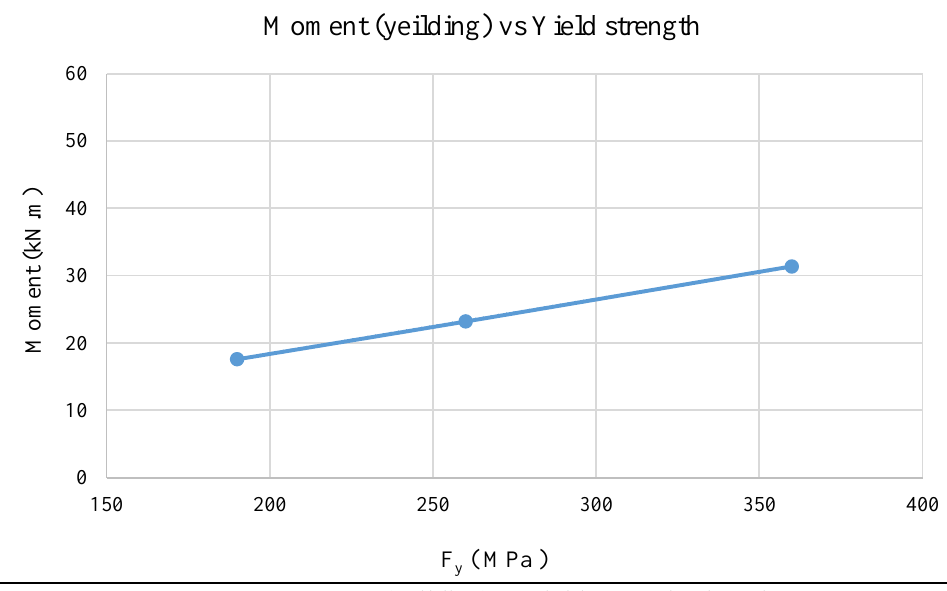
Fig. 11. Moment (yeilding) vs yield strength of steel. Details of specimens for different ultimate strength of concrete Specimens Number